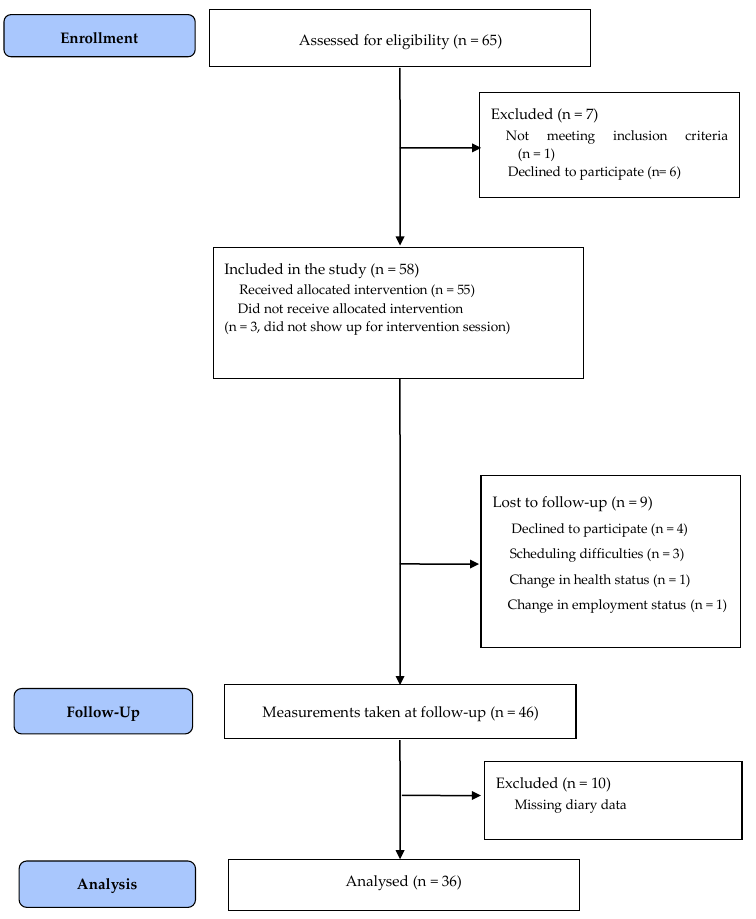
Figure 1. CONSORT flow diagram showing the flow of participants through each stage of the